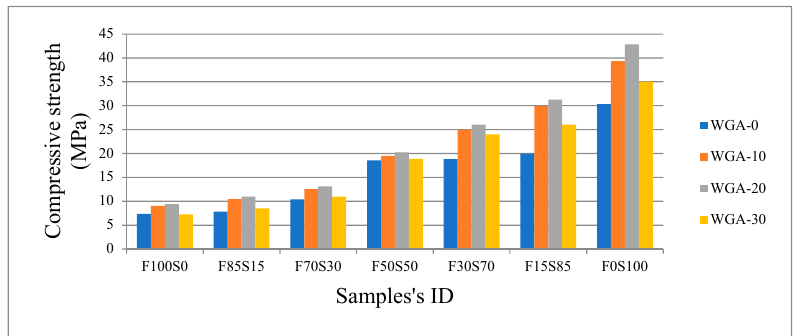
Figure 4. Compressive strength versus FA / GGBS and WGA solution.